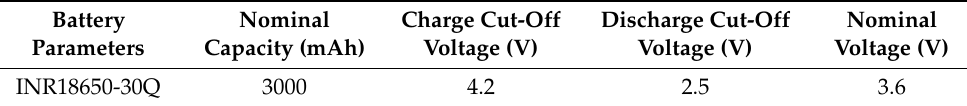
Table 1. Parameters of INR18650-30Q